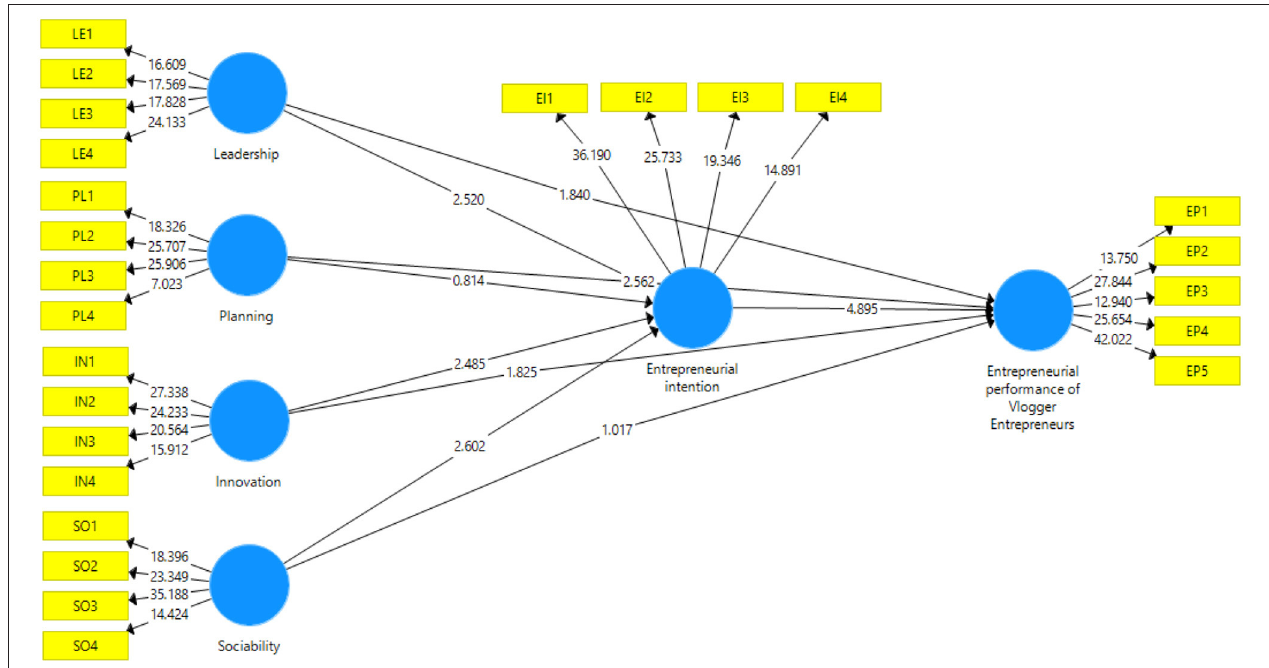
FIGURE 3 | SmartPLS bootstrapping